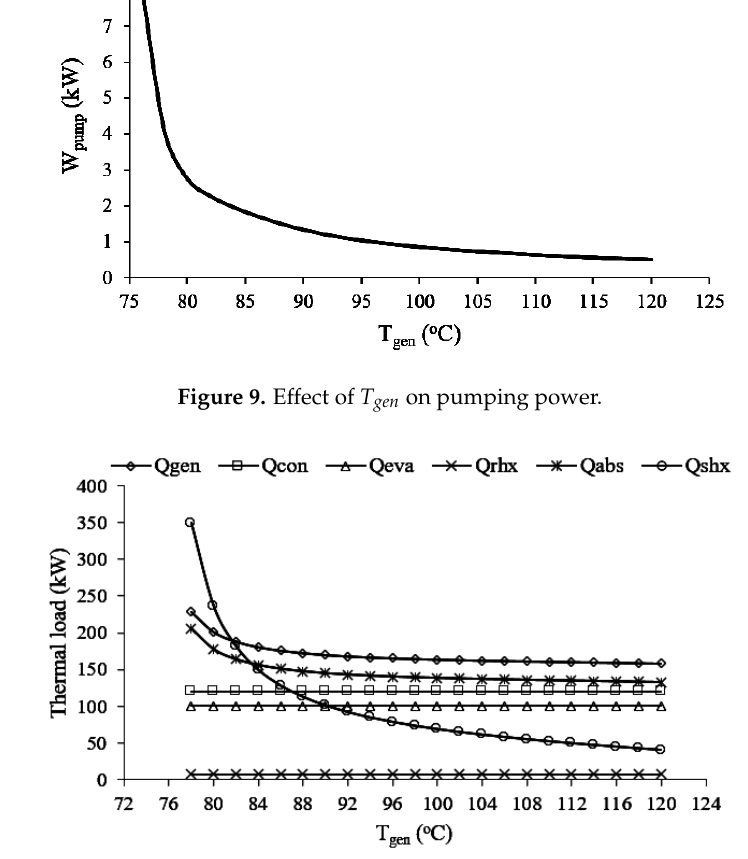
Figure 10. Effects of T gen on Components’ thermal loads.